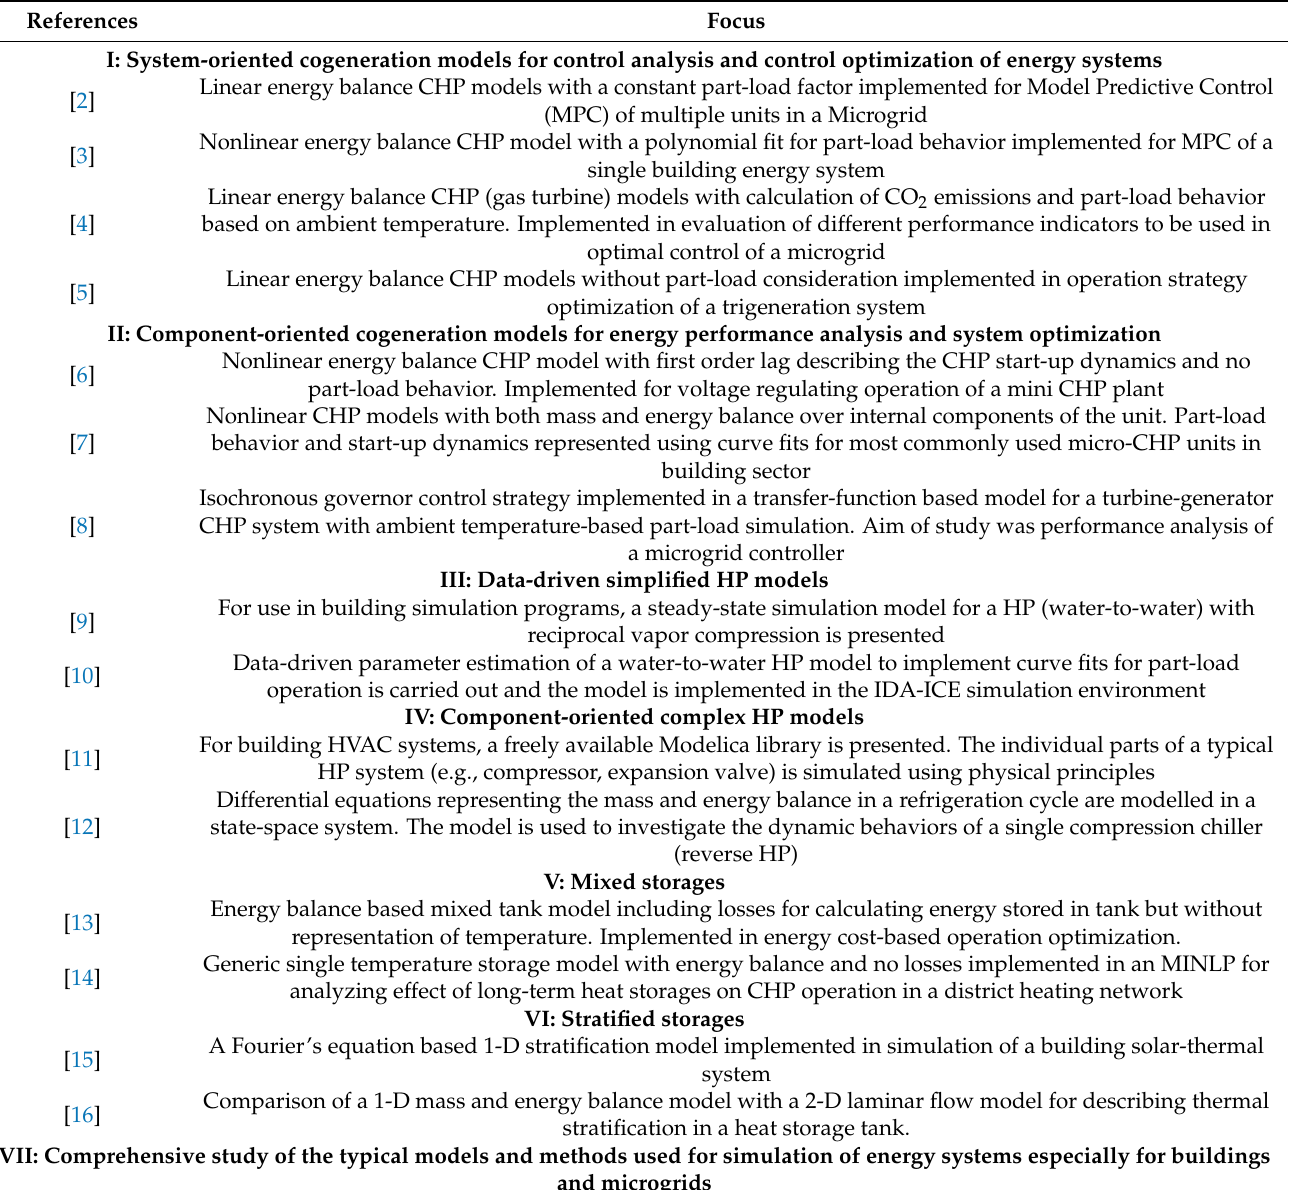
Table 1. Selected literature review on cogeneration, HP and storage tank models and comparison of energy system